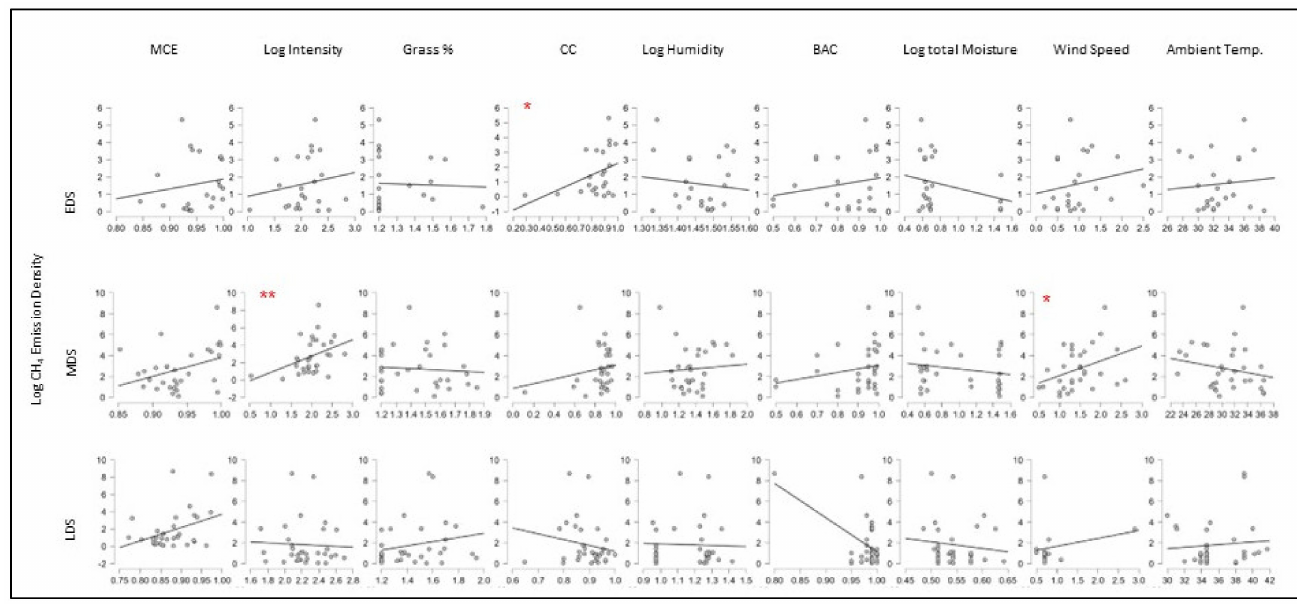
Figure 10. Methane ED ( log ) Correlation Plots for Key Variables by Fire Type (*** p < 0.001, ** p < 0.01, * p < 0.05).